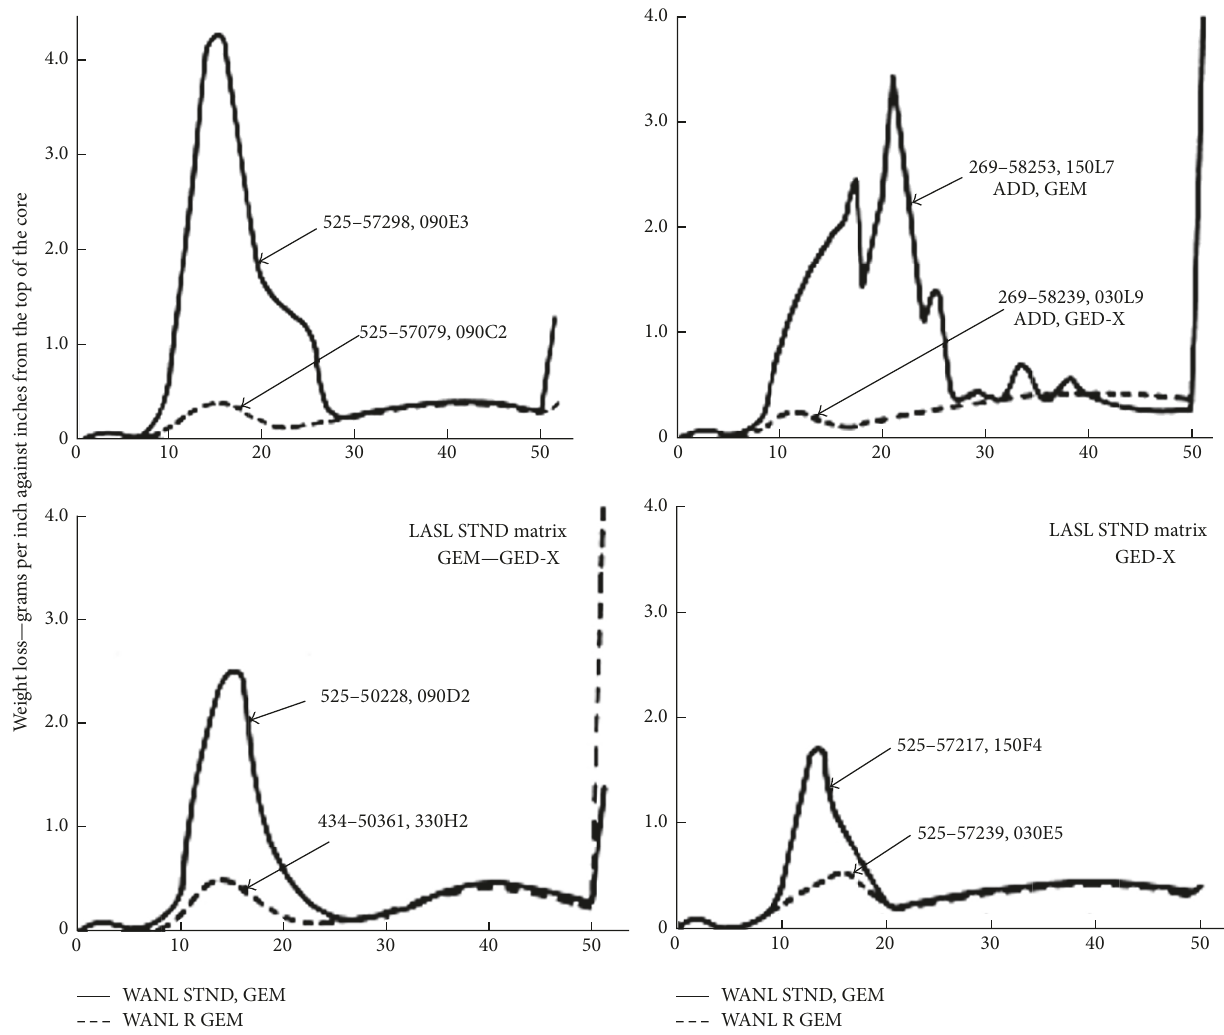
Figure 5: Incremental mass losses of some WANL and LASL Pewee fuel elements [12]. WANL: fabricated by Westinghouse Astronuclear Laboratory; LASL: fabricated by Los Alamos Scientific Laboratory; GED-X: G end, diffusion coating of cores and OD surfaces with NbC followed by bore overcoating with molybdenum; GED: G end, low temperature, methane assisted coated of bores and OD surfaces with NbC; STND: normal four, Thermax, and Varcum matrix; R: standard matrix impregnated with niobium resinate; ADD: standard matrix with 2.5 volume percent NbC powder additive. Numbers on the various corrosion curves are the serial numbers for the elements in specific